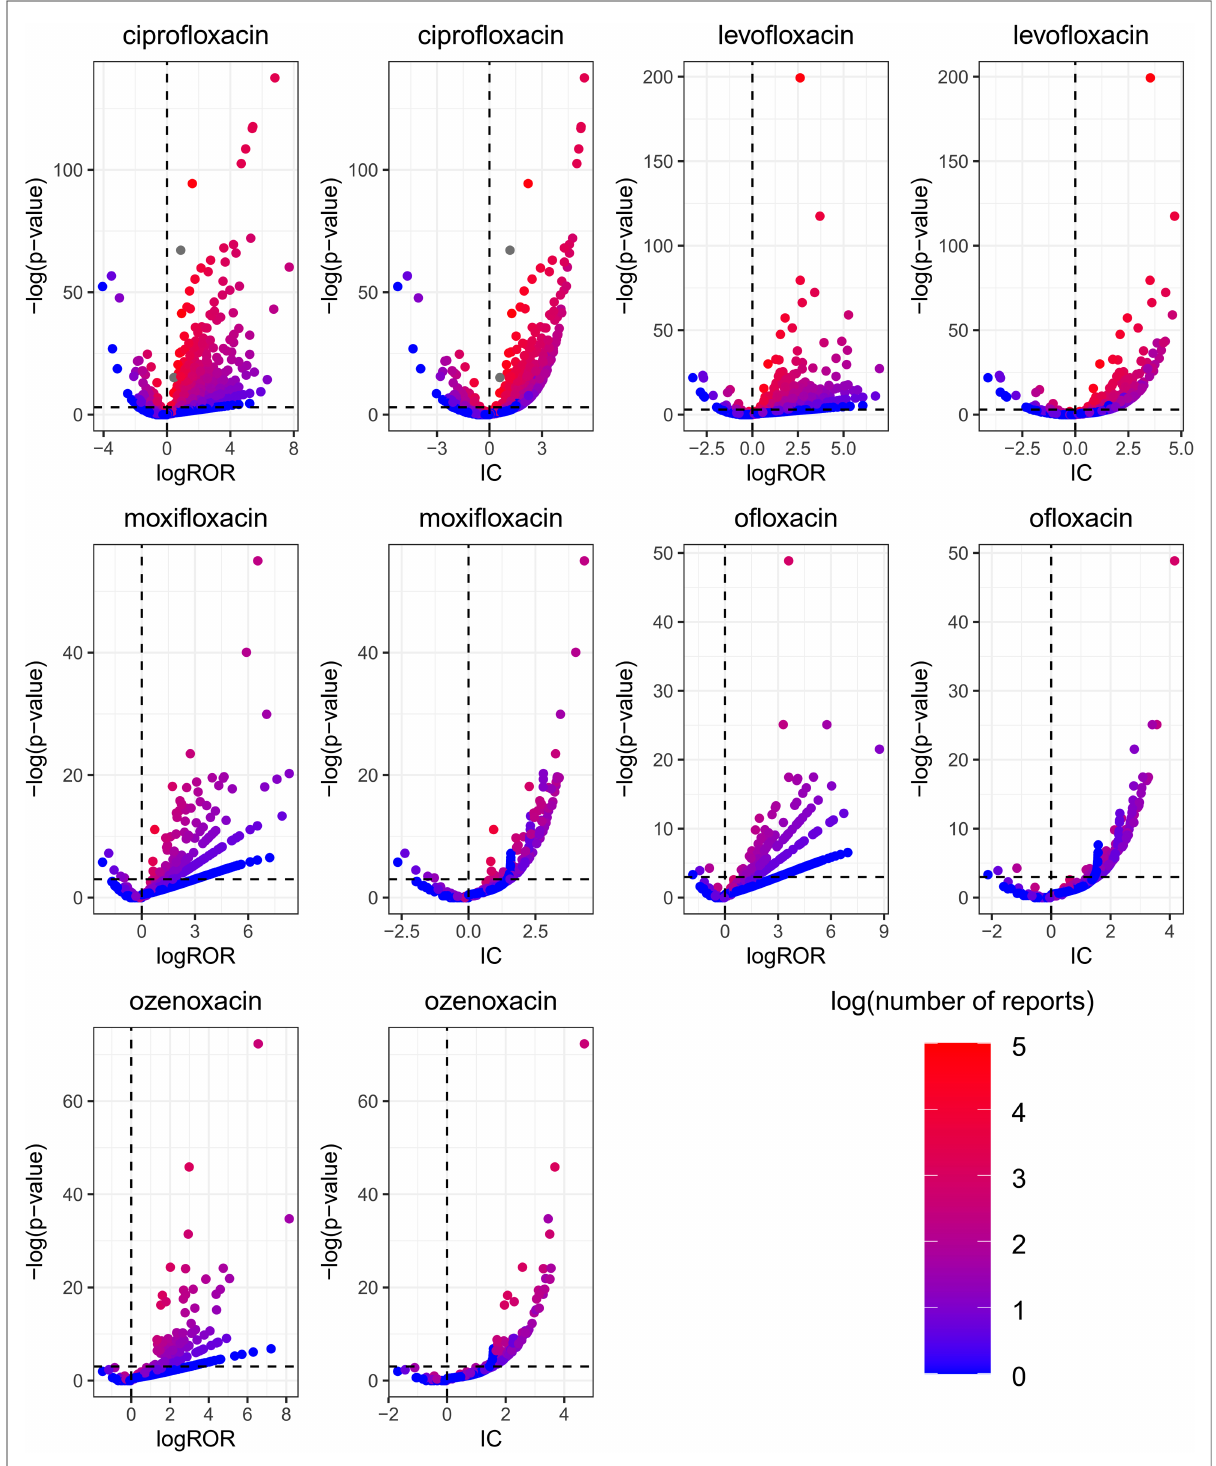
FIGURE 1 Quinolones associated with signals of AE reports. The x-axis is the logarithm of the reporting ROR (log ROR) or IC, and the Y-axis is the negative logarithm of the P -value calculated using Fisher ’ s exact test ( − log P -value). The positive y-direction represents a strongly signi fi cant difference. The colors of the individual points represent differences in the log of the number of reports for each PT. In this scatterplot, the signal is larger for the points plotted in the upper right corner. The blue-to-red colors represent the number of times an adverse effect was